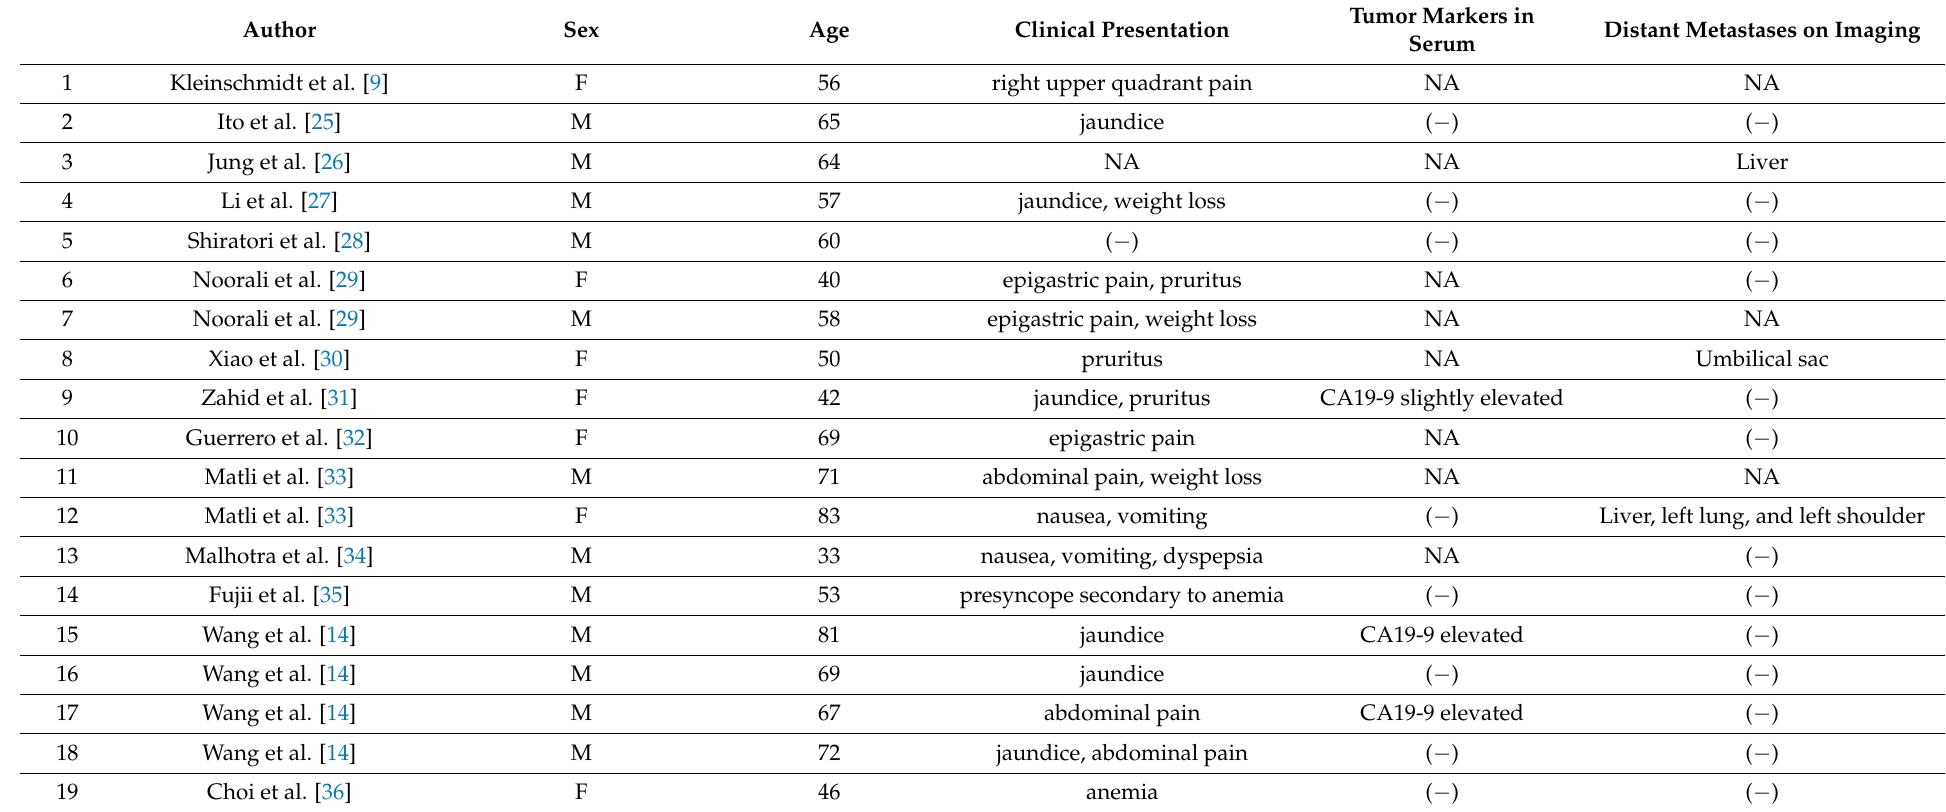
Table 1. Summary of the literature review of cases of ampullary neuroendocrine neoplasms from May 2020 until April